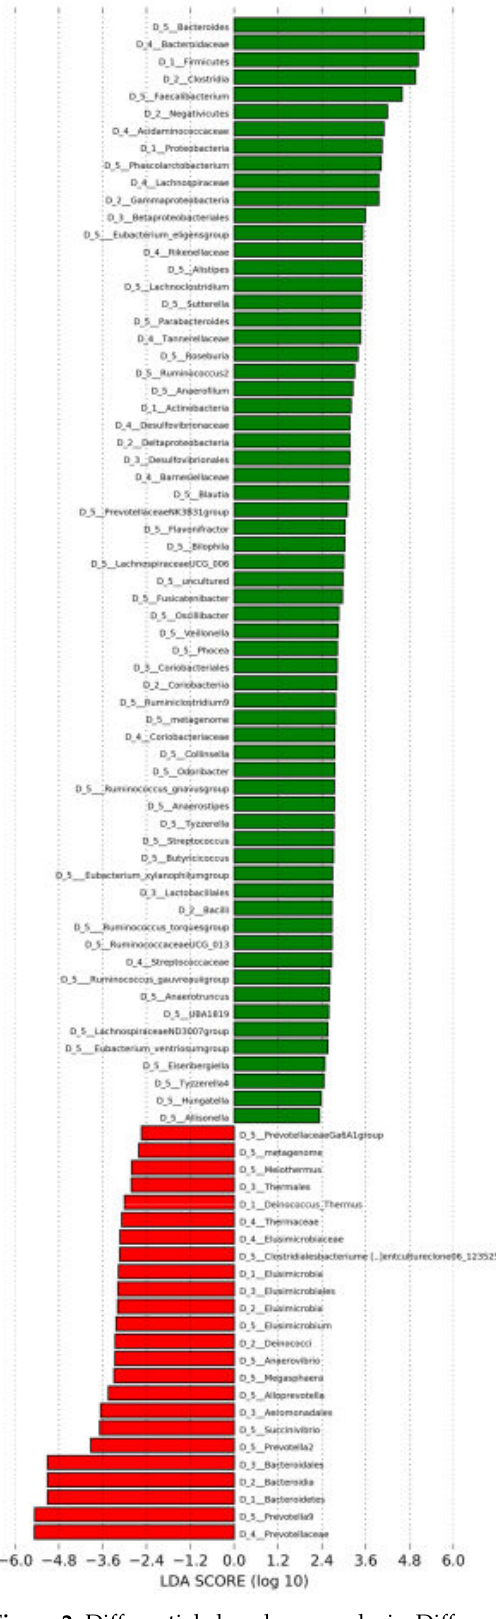
Figure 2. Differential abundance analysis. Differential abundant taxa were identified for EnP (red) and EnB (green) using LEfSe with the criteria LDA score ≥ 2.0 and p -value <